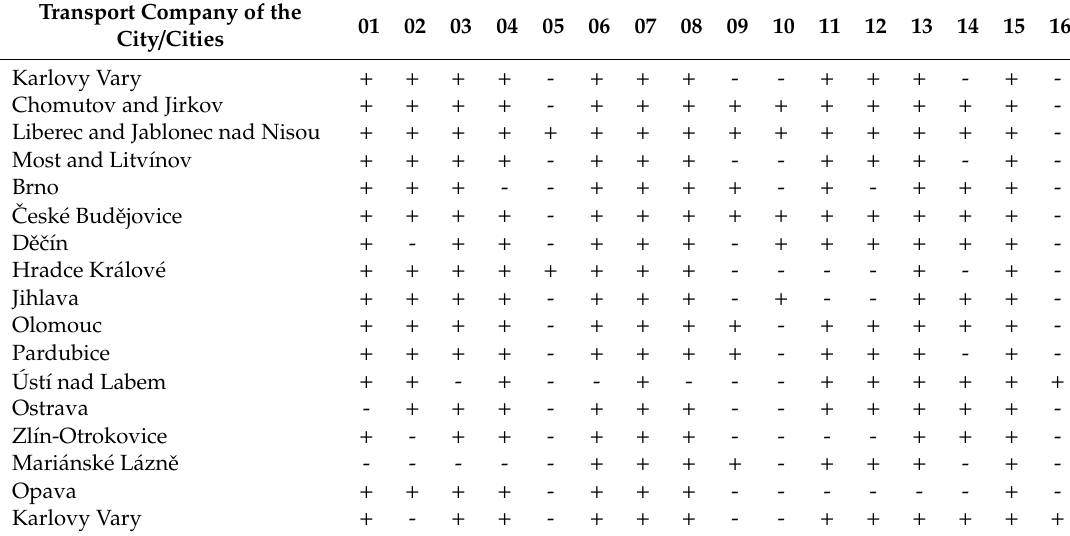
Table 6. Nature of the change resulted from inclusion of Transport Company Prague in the analysis. Transport Company of the City/Cities